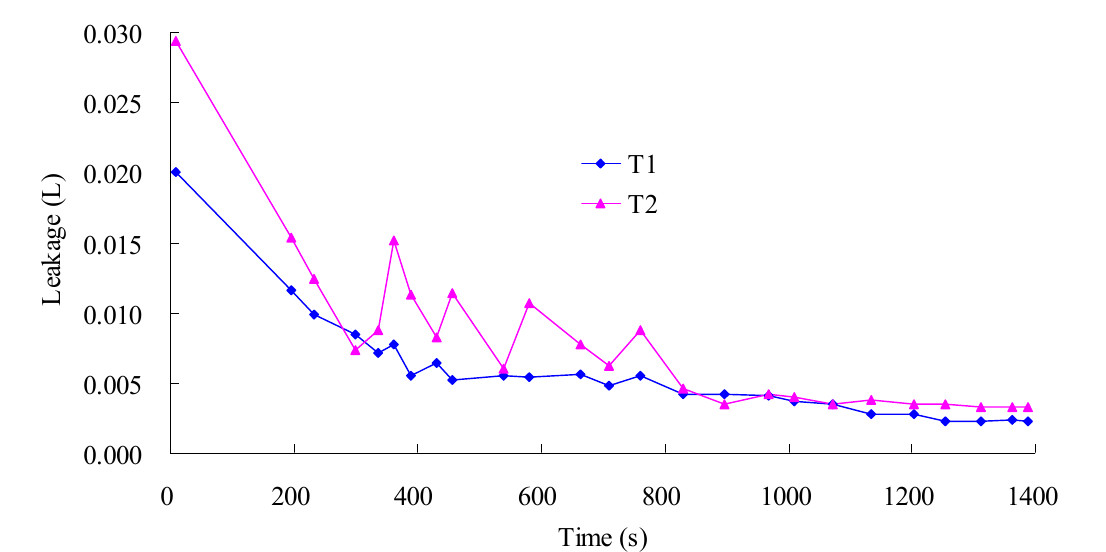
Figure 4. Curve of infiltration rate and time for permeability tests.